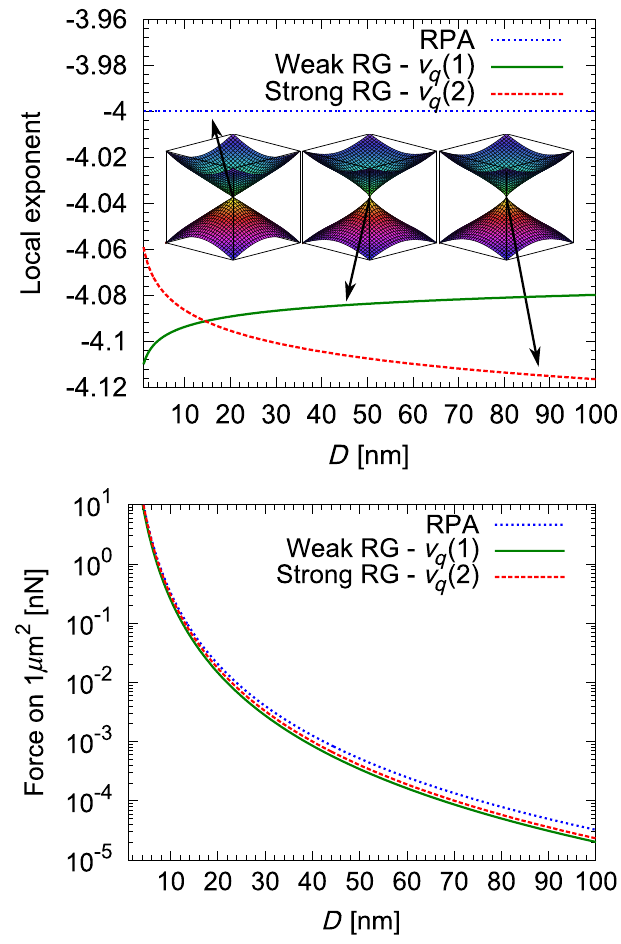
FIG. 3. Plot of the local exponent p ð D Þ ¼ ð d log j F j =d log D Þ of the force (top, with band-structure inset) and the force F ¼ ð dE ð 2 Þ =dD Þ (bottom) using the RPA (dotted line), v ð 1 Þ q [Eq. (4), ð 2 Þ β ¼ 2 = π 2 , dashed line]. Here, solid line], and v q [Eq. (5), with we fix v ¼ 10 5 m = s and Λ ¼ 1 = ð 1 . 42 Å Þ